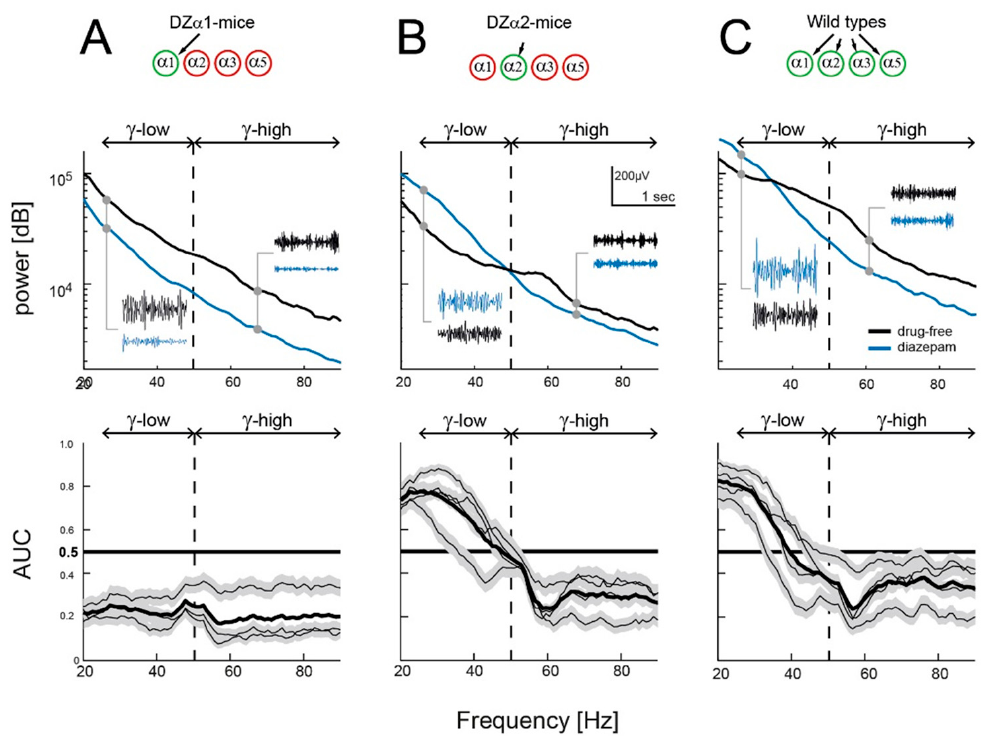
Figure 3. Effect of diazepam on γ -power in ( A ) DZ α 1-, ( B ) DZ α 2- and ( C ) wild type-mice. Upper panels: Trial-averaged power spectra calculated for a frequency range of 20 to 90 Hz. One representative animal for each group of genotypes is shown (number of trials for drug-free/diazepam: DZ α 1 = 282/314; DZ α 2 = 340/316; wildtype = 294/437). Small insets: raw local field potentials (LFPs) were filtered to pass frequencies between 20–50 Hz (low γ -range) and 50–90 Hz (high γ -range), respectively. Lower panels: Effects of diazepam on LFP power as the area under the receiver operating characteristics curve (AUC) for each mouse (thin black lines; gray field: [0.025 0.975] bootstrapped prediction interval) and averaged across mice for all genotypes (thick lines). An AUC of 0.5 indicates the absence of an effect (horizontal black line).